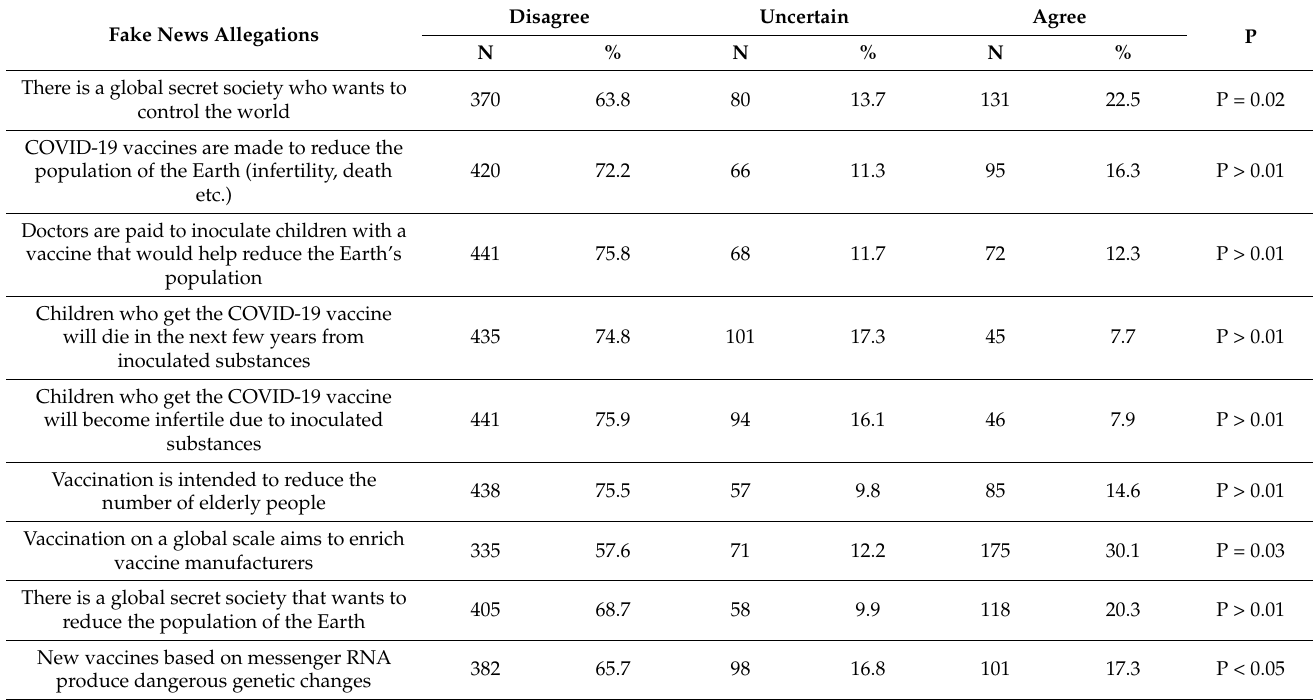
Table 10. Identifying the degree of trust given to “fake news” statements